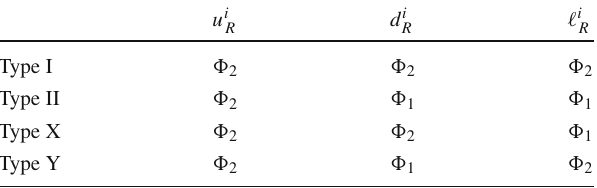
Table 1 Higgs coupling to up-type quarks, down-type quarks and lep- tons in types allowed by the Z 2 symmetry. The superscript i is a gener-